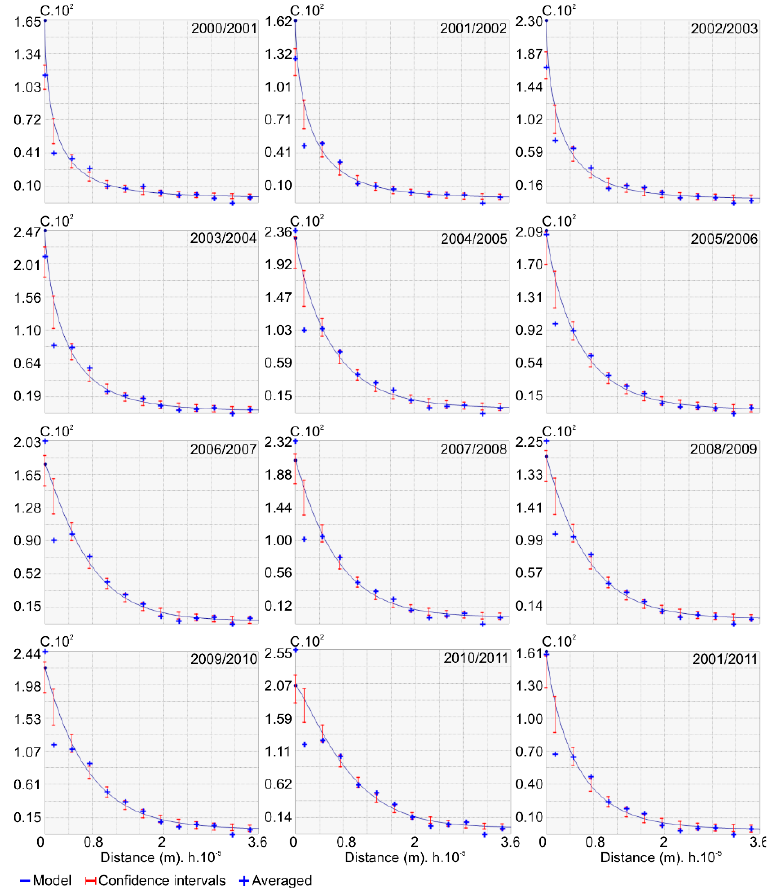
Figure 6. Empirical covariance values (crosses), estimated point of the stable covariance model (line), and bars with the 90% confidence intervals of the binomial areal kriging of the probability of occurrence of soybean crop areas per harvest period and the averaged years (2001/2011).